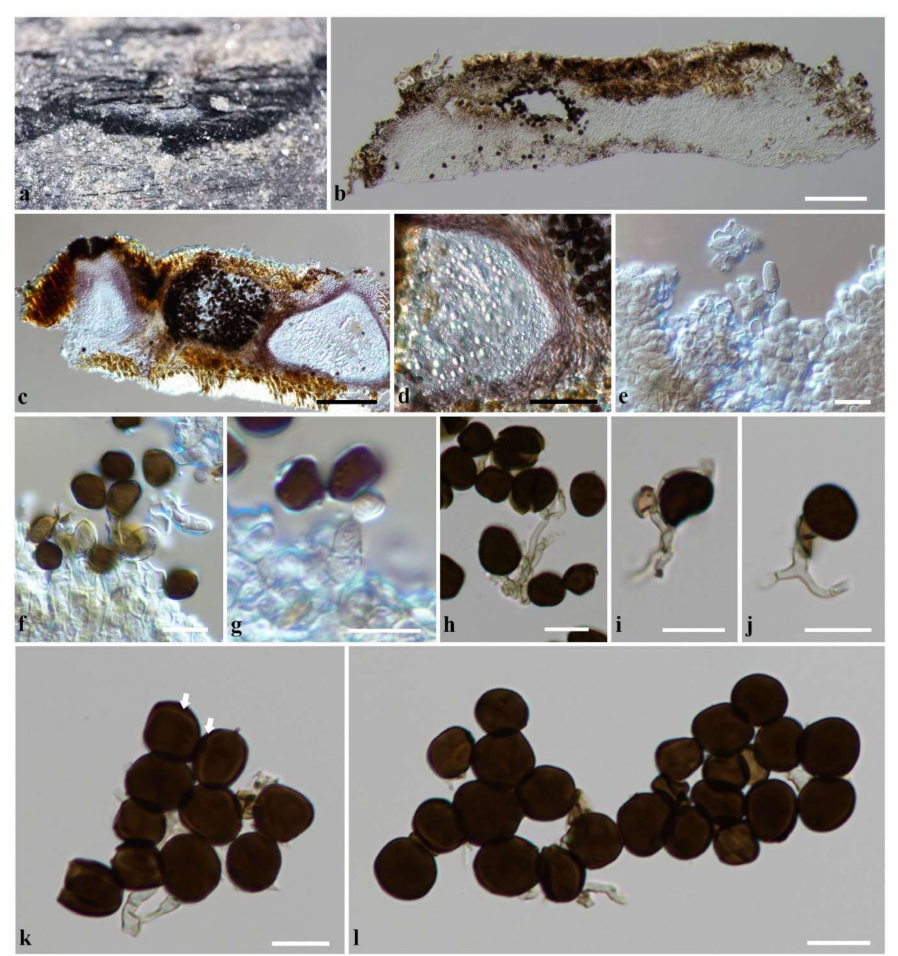
Figure 4. Apiospora locuta-pollinis (KUN-HKAS 124566). ( a ) Conidiomata on host substrate. ( b , c ) Sec- tion through the stromata. ( d ) Section through pycnidial wall. ( e ) Conidiophore mother cells. ( f , g ) Conidiogenous cells giving rise conidia. ( h – j ) Conidiophores (sterile cells attached to the conid- iophore in ( i , j )). ( k , l ) Conidia (equatorial slit is indicated by arrows in ( k )). Scale bars: ( b , c ) = 100 µ m, ( d ) = 50 µ m, ( e – l ) = 10 µ